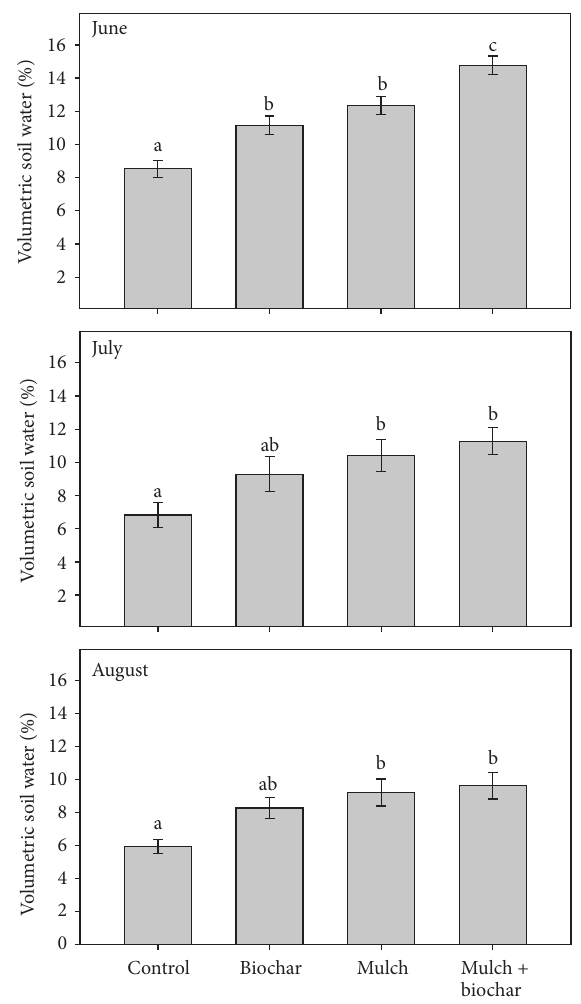
Figure 2: Volumetric soil water content (0–10cm depth) under post-wildfire rehabilitation treatment at the Church’s Park burn, Colorado. Soil water was measured at 6 replicate blocks of treat- ments, 6 times per year during 2014, 2015, and 2016. Bars show means and standard errors of six replicate treatment blocks. Letters denote significant differences among means at 𝛼 = 0.05 level.